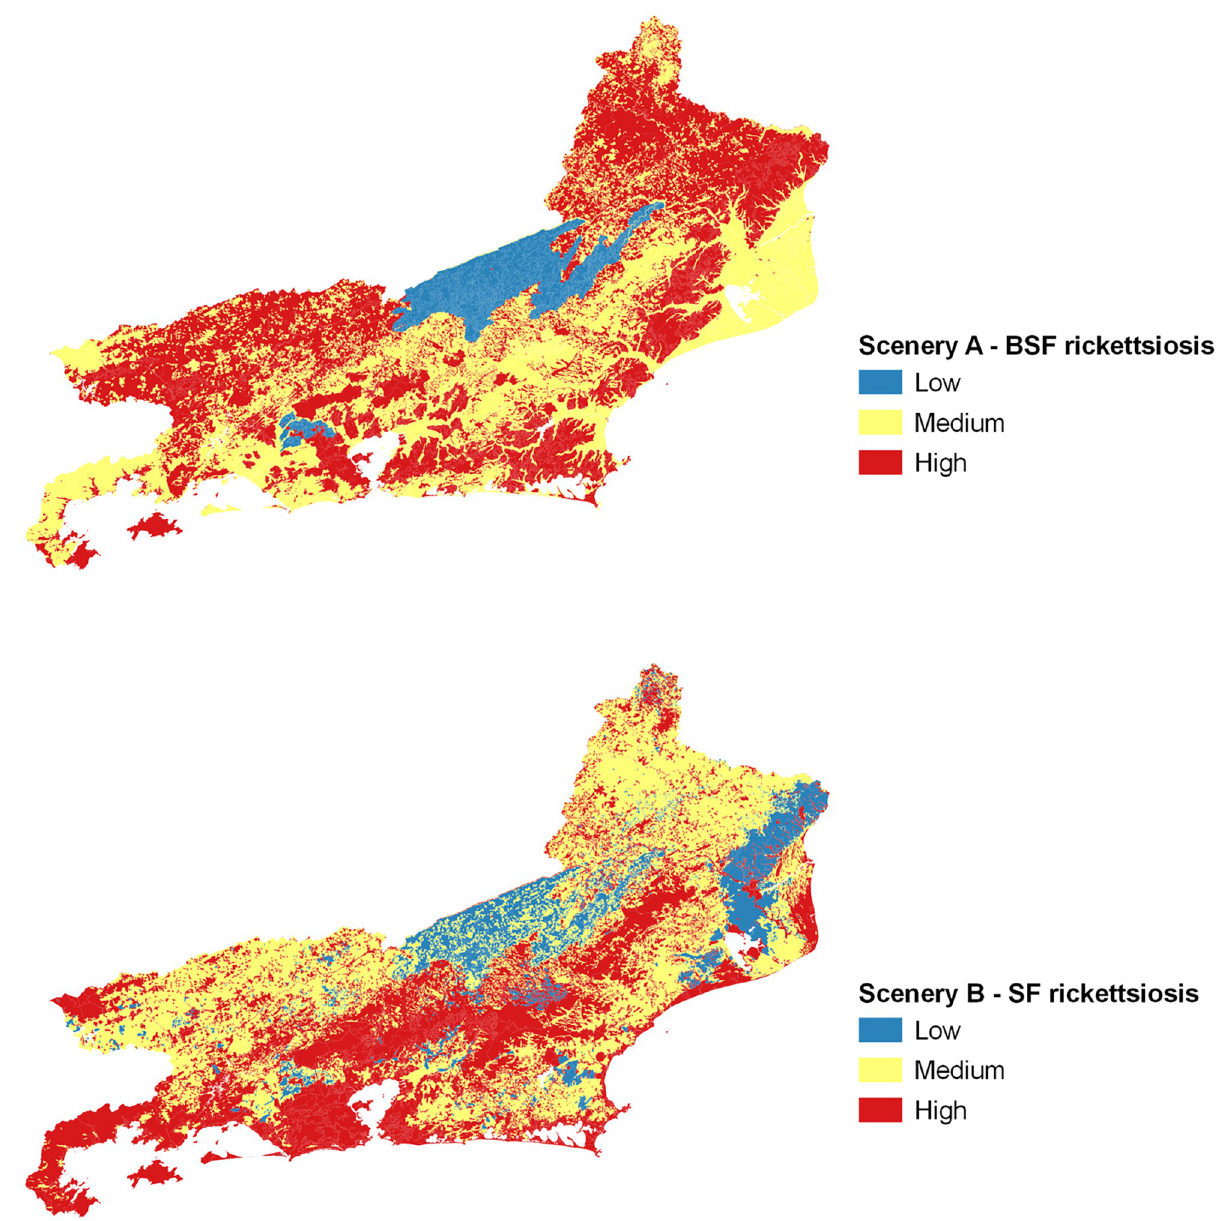
Fig 4. Spotted fever rickettsiosis potential risk Map to Rio de Janeiro state, Brazil. Synthesis Sceneries A (BSF) and B (SF) Scenery A (BSF); Scenery B (SF); Three colours’ scale: blue colours—low potential risk; yellow colours—medium potential risk; red colours—high potential risk.